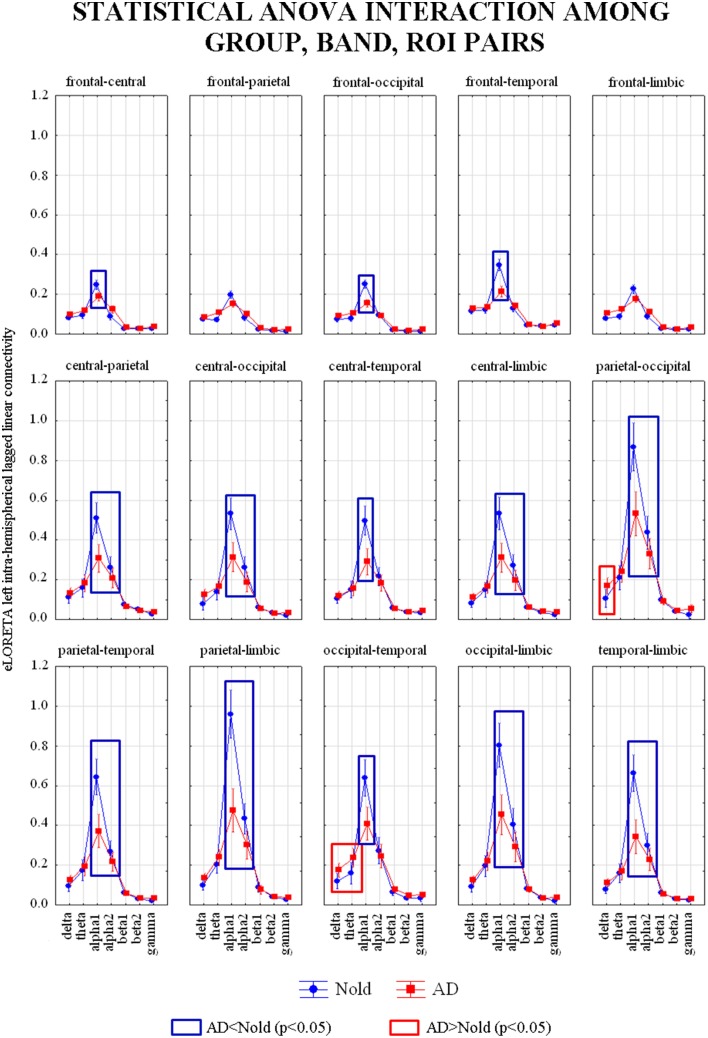
Diagram showing the grand average of the EEG intra-hemispherical lagged linear connectivity computed between each pair of regions of interest (ROI) in the left hemisphere. These values refer a statistically significant ANOVA interaction [F(84, 18312) = 8.5942, p < 0.0001] among the factors Group (AD, Nold), ROI pairs (frontal-central, frontal-parietal, frontal-occipital, frontal-temporal, frontal-limbic, central-parietal, central-occipital, central, temporal, central-limbic, parietal-occipital, parietal-temporal, parietal-limbic, occipital-temporal, occipital-limbic, and temporal-limbic), and Band (delta, theta, alpha 1, alpha 2, beta 1, beta 2, gamma). Subjects' age, education, IAF, and gender were used as covariates. Legend: the rectangles indicate the ROI pairs and frequency bands in which connectivity values presented the pattern Nold ≠ AD (Duncan test, p < 0.05).